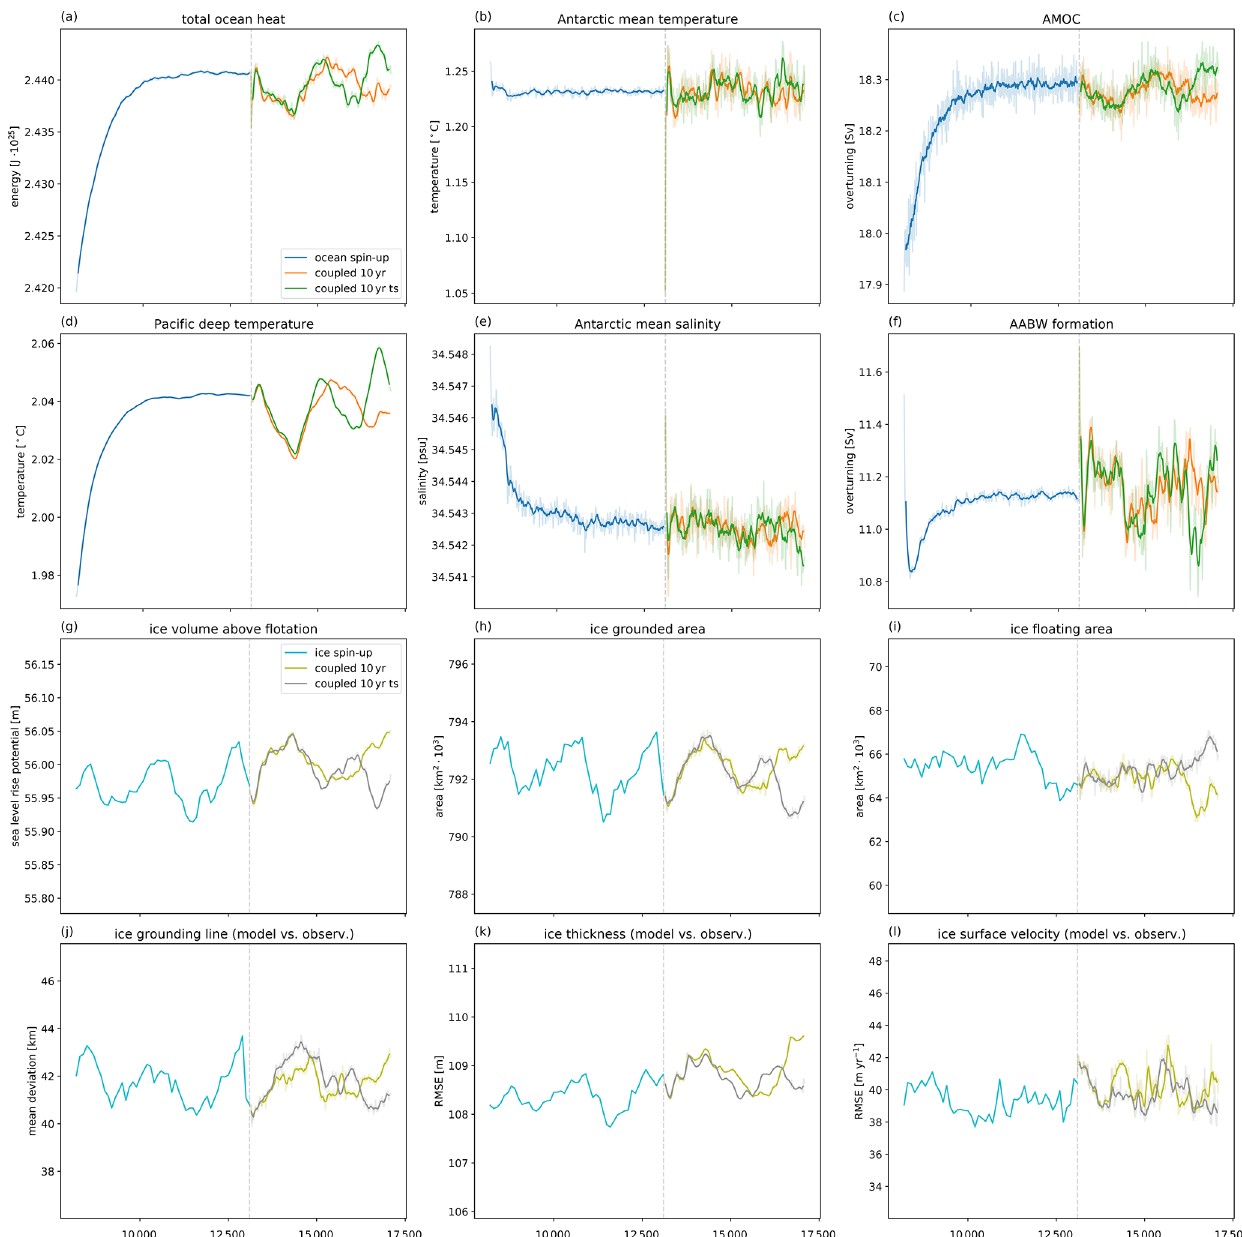
Figure 10. Evolution of the Antarctic Ice Sheet and the global ocean during spin-up and coupled simulations under constant climate forcing. Details about ocean (a–f) and ice metrics (g–l) are given in Section 5.3. Coupling starts at the vertical dashed line. Two coupling variants are presented, both using a coupling time step of 10 years, while one passes the time series of ocean forcing to the ice model (denoted as “ts”). Light and solid lines are 10- and 100-year running means